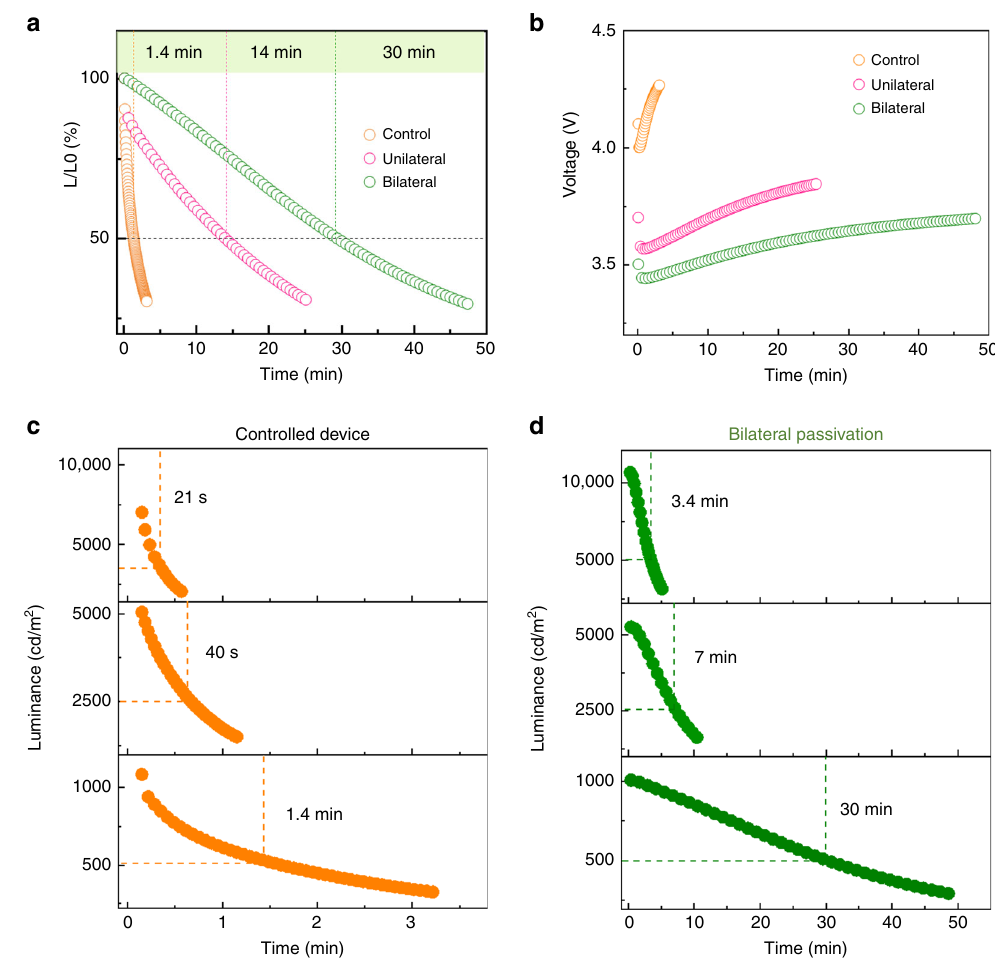
Fig. 6 Stabilities of QD fi lm and LED device. a Operational lifetimes of pristine and bilateral-passivated QD fi lms at a initial luminance of about 1000cd m − 2 . b Voltage shifts of perovskite QD LEDs at a constant current density. c Operational lifetimes of pristine device tested at different initial luminance, 1000cd m − 2 , 5000cd m − 2 , and 7000cd m − 2 . d Operational lifetimes of bilateral-passivated device tested at different initial luminance, 1000cd m − 2 , 5000cd m − 2 , and 10000cd m − 2 . These results demonstrate the bilateral passivation could obviously increase the stability of QD materials and devices. Source data are provided as a Source Data fi